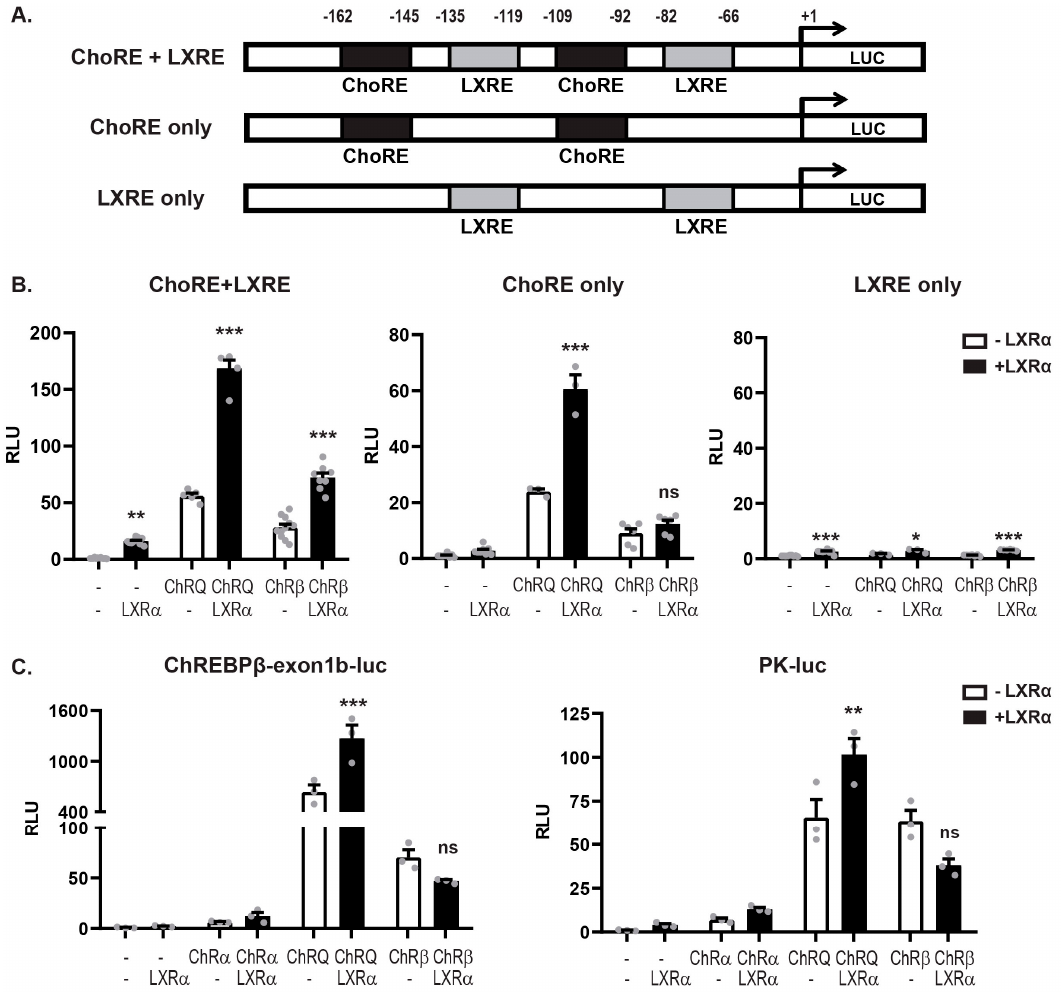
Figure 3. LXR α :ChREBP α co-activation requires functional ChoREs but not LXREs. ( A ). Schematic representation of the synthetic luciferase reporters constructs. ChoRE, carbohydrate response